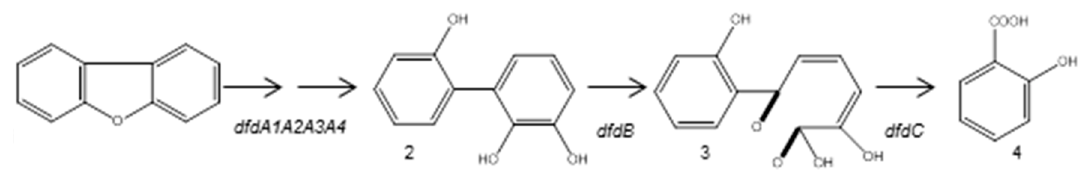
Figure 6. Proposed degradation pathway of DF by Nocardioides sp. DF412. Genes involved in each reaction are specified below each arrow. Compound definition: dibenzofuran ( 1 ); 2,2’,3- trihydroxybiphenyl ( 2 ); 2-hydroxy-6-(2-hydroxyphenyl)-6-oxo-2,4-hexadienoic acid ( 3 ); and